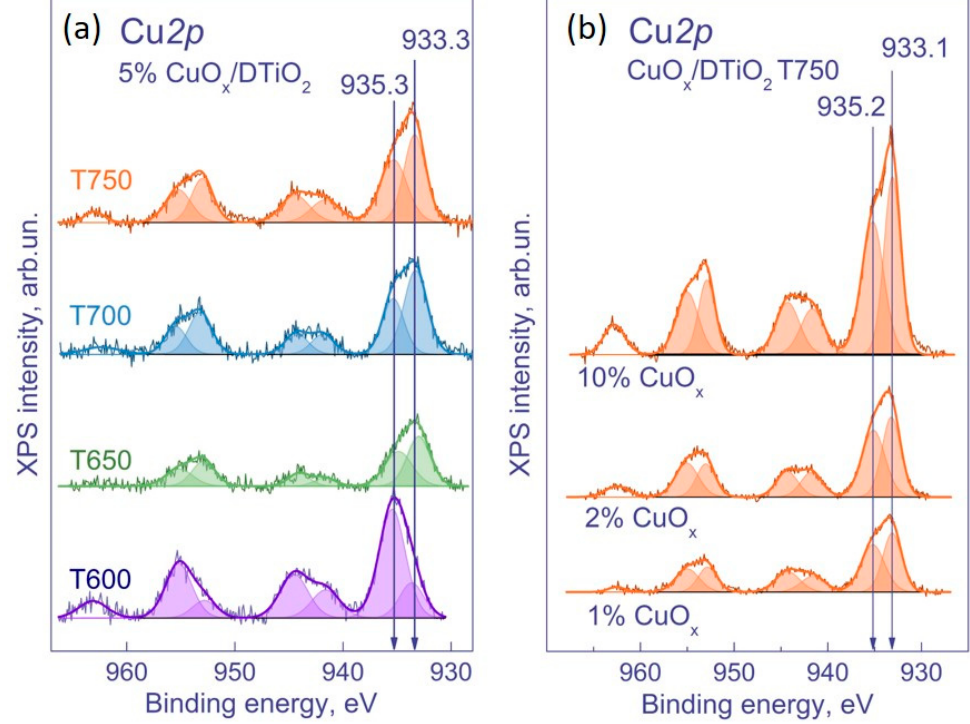
Figure 4. XPS spectra of Cu 2p ( a ) 5% CuO x /DTiO 2 T600–T750; ( b ) (1–10)% CuO x /DTiO 2 T750.